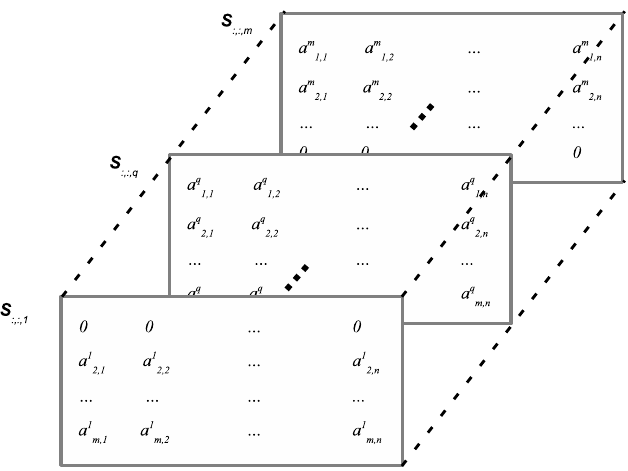
Figure 2. A three-dimensional CIS tensor, denoted by S